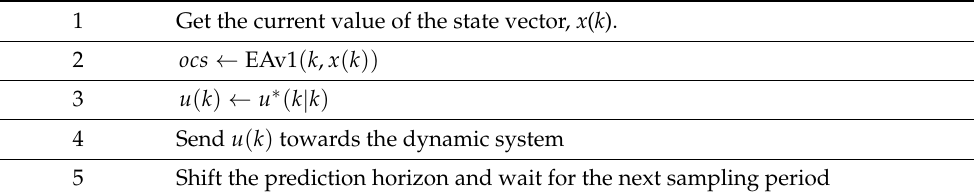
Table 1. Outline of Receding Horizon Controller using an